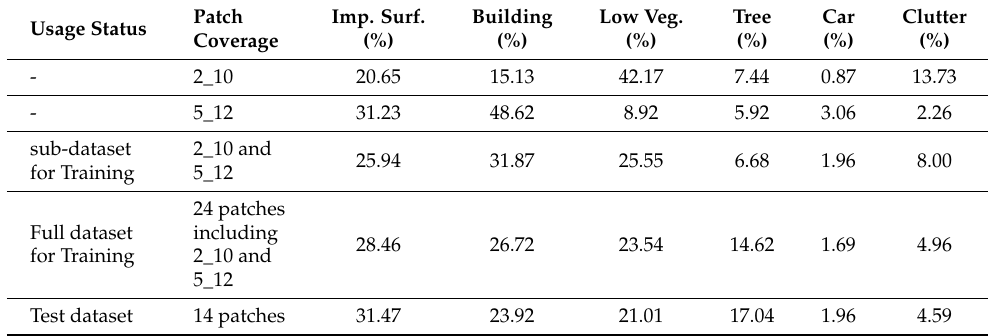
Table 2. Class distribution of Potsdam training